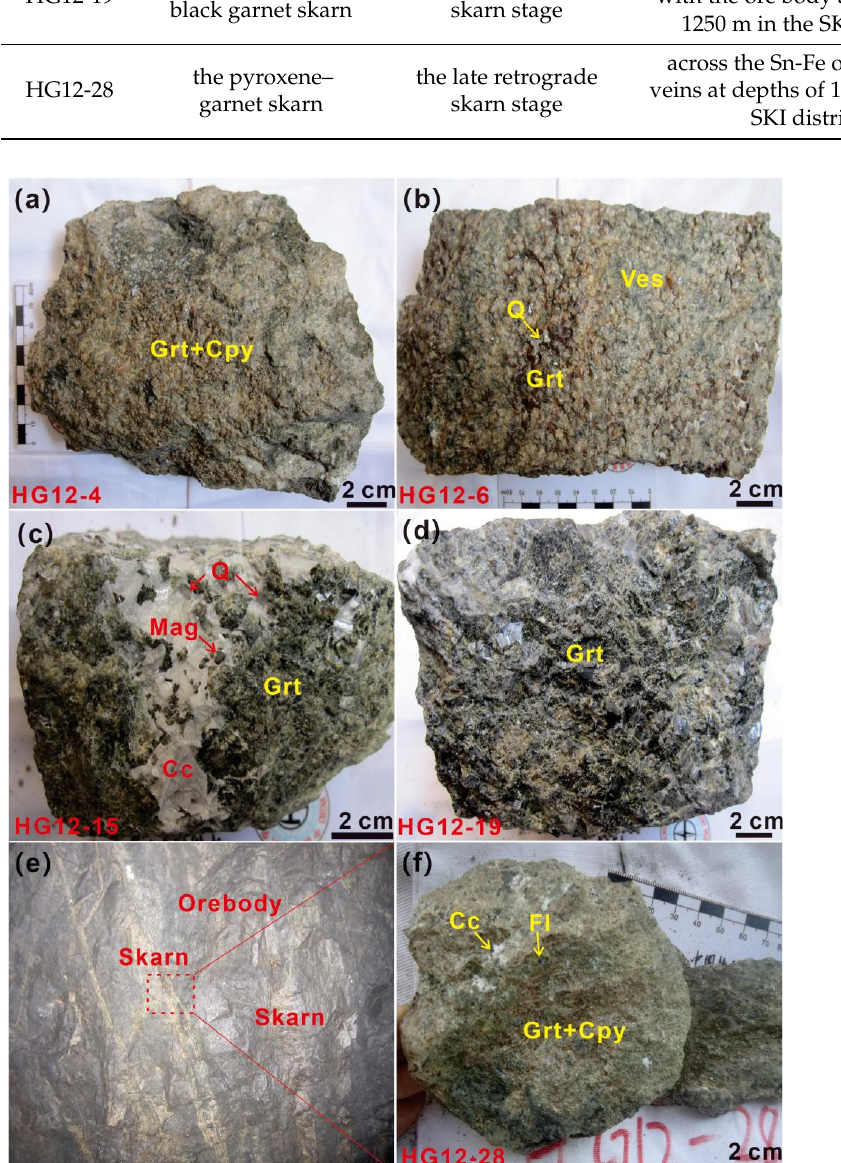
Figure 4. The field observation and microscope photographs of garnet skarn from different miner- alization stages of the Huanggang deposit. ( a ) Massive pyroxene – garnet skarn (sample HG12-4). ( b ) Massive vesuvianite – garnet skarn surrounded by the quartz (sample HG12-6). ( c ) Disseminated ore-bearing skarn cut by later quartz and calcite veins (sample HG12-15). ( d ) Massive giant-grained black garnet skarn (sample HG12-19). ( e ) The later skarn (sample HG12-28) cut across the massive ore body as veins. ( f ) Clinopyroxene – garnet skarn surrounded by fluorite and calcite. Mineral abbreviations: Grt, garnet; Cpy, clinopyroxene; Ves, vesuvianite; Q: quartz; Cc, calcite; Mag, mag- netite; Fl: fluorite.